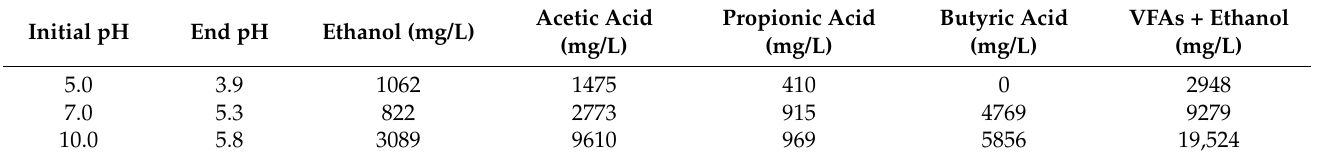
Table 2. VFAs content in different type fermentation broth.